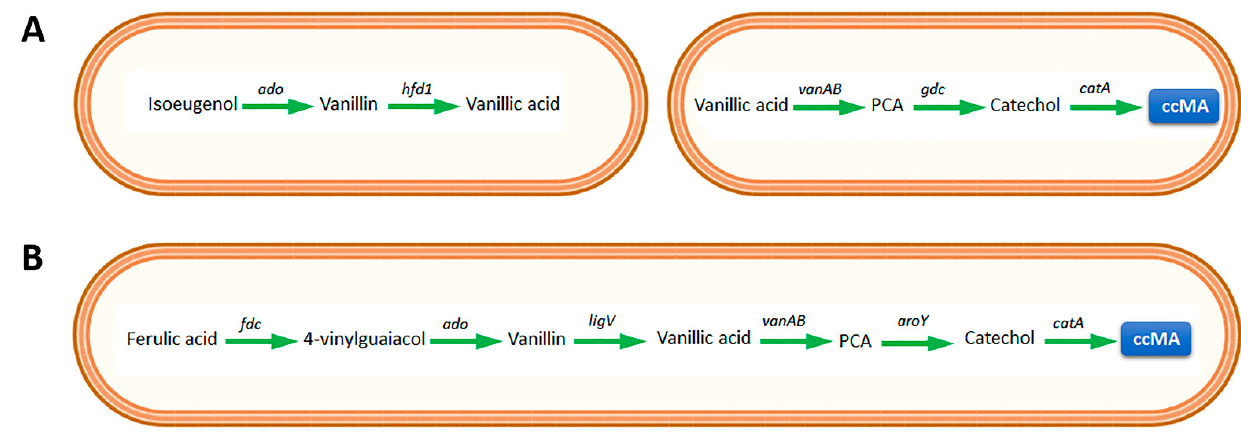
Figure 4. Synthesis of ccMA from ( A ) isoeugenol in a two-step approach [87], and from ( B ) ferulic acid in one-pot [86] using engineered Escherichia coli strains. Encoding genes: ado , aromatic dioxygenase; aroY , protocatechuate decarboxylase; catA , catechol 1,2-dioxygenase; fdc, phenolic acid decarboxylase; gdc , gallate decarboxylase; hfd1 , aldehyde dehydrogenase; ligV , vanillin dehydrogenase; vanAB , vanillate demethylase. Green arrows show overexpressed pathways.